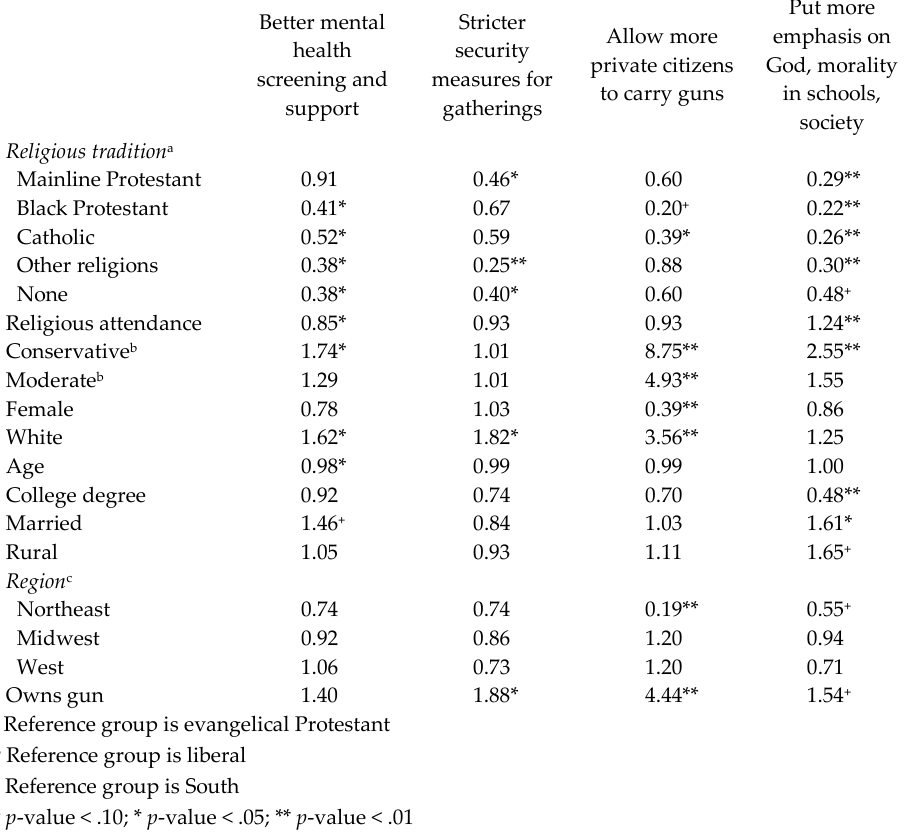
Table 5. Estimated odds ratios predicting what is “most important” for preventing mass shootings (reference category: “stricter gun control laws and enforcement”).